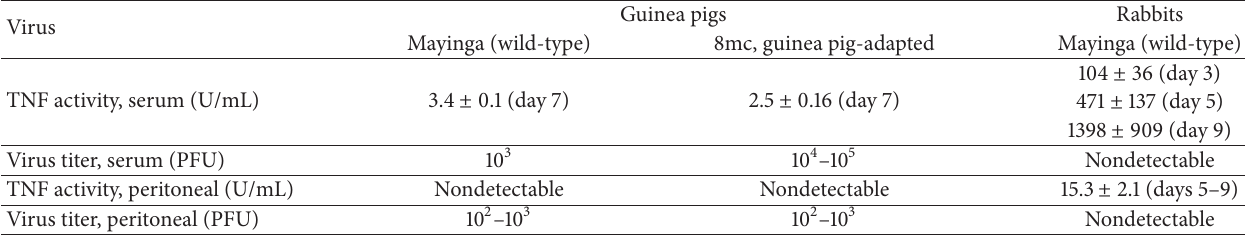
Table 3: Serum and peritoneal TNF activity in EBOV-infected guinea pigs and